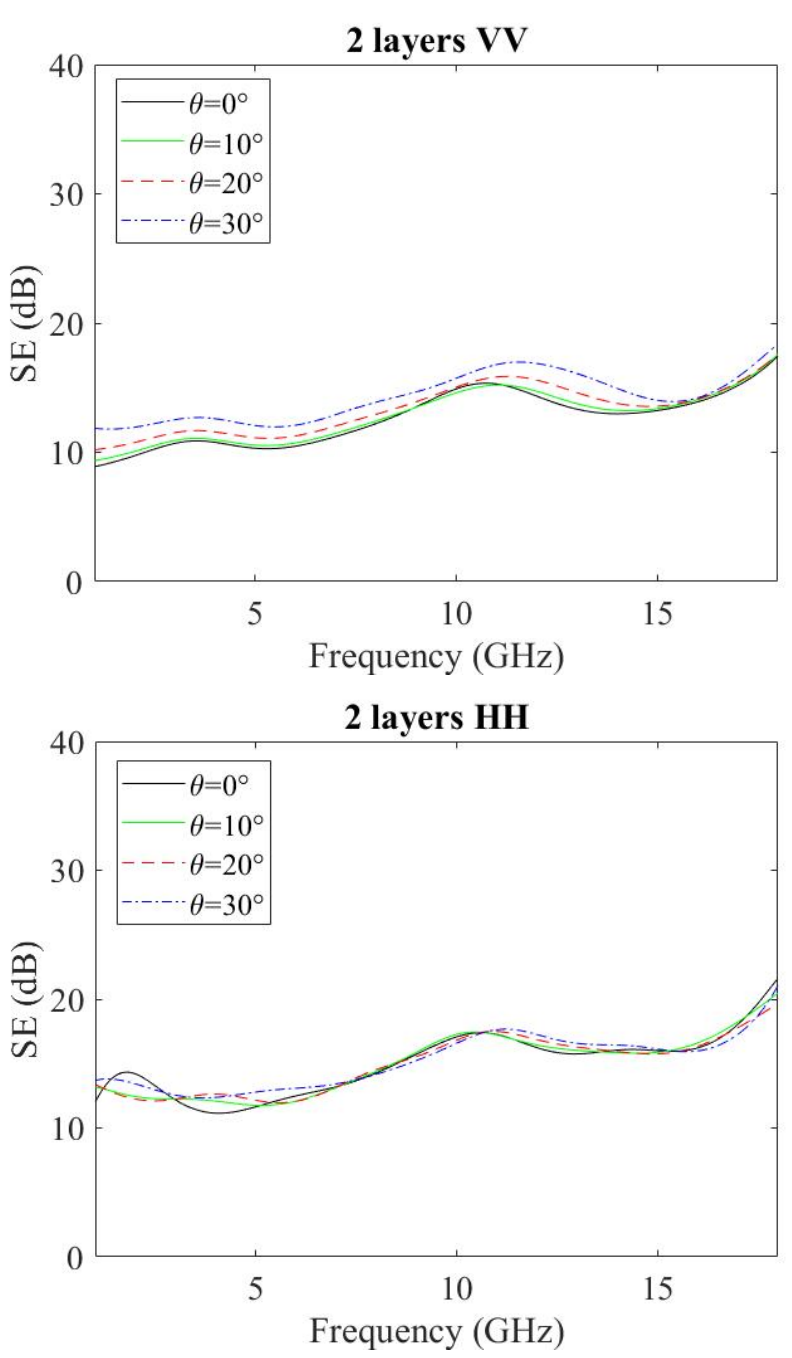
Figure 8. Plots of the SE versus frequency of a sample with 2-layer biochar coating for different angle of incidence. Vertical polarization ( top panel ). Horizontal polarization ( bottom panel ).